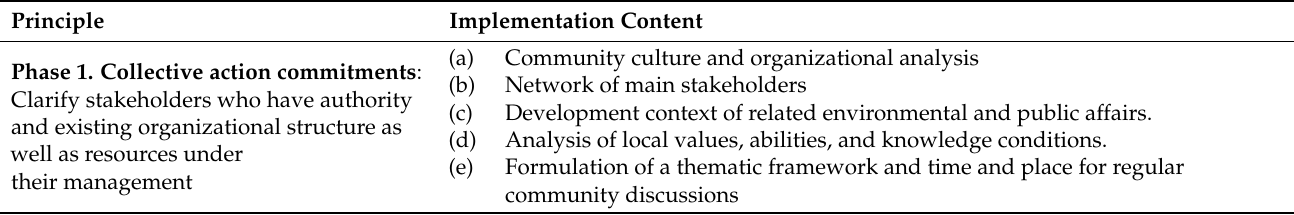
Table 3. List of implementation contents for each planning